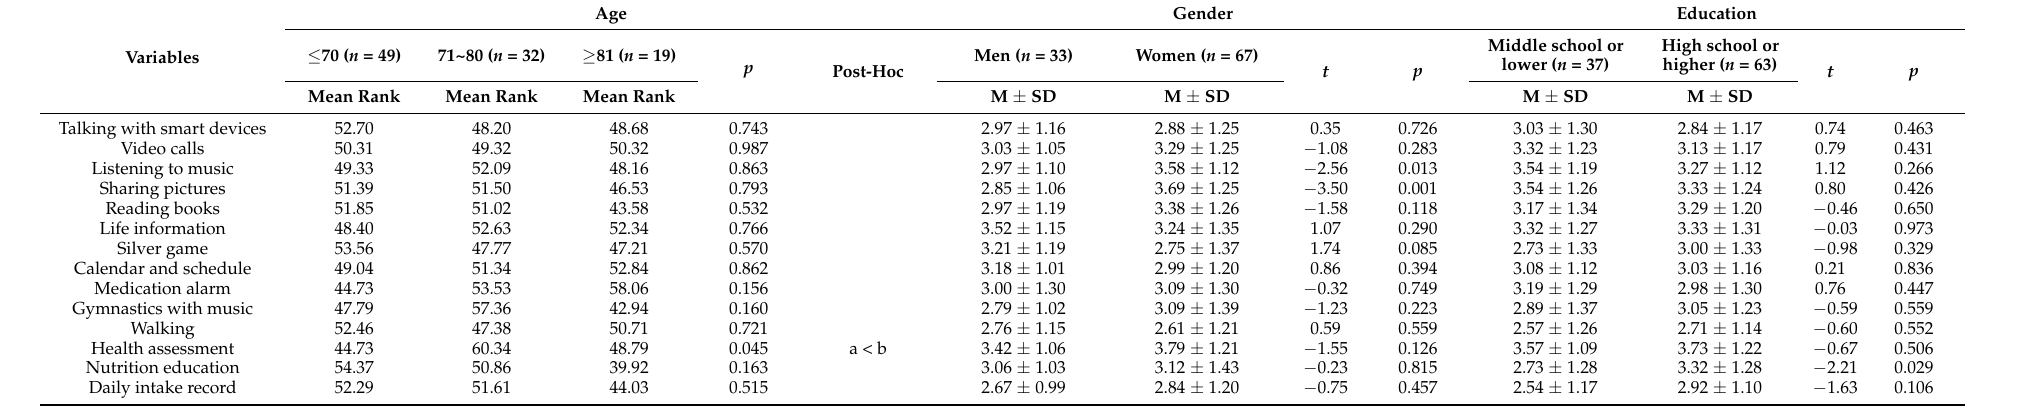
Table 4. Differences in preference related to non-face-to-face services according to age, gender, and education (N =